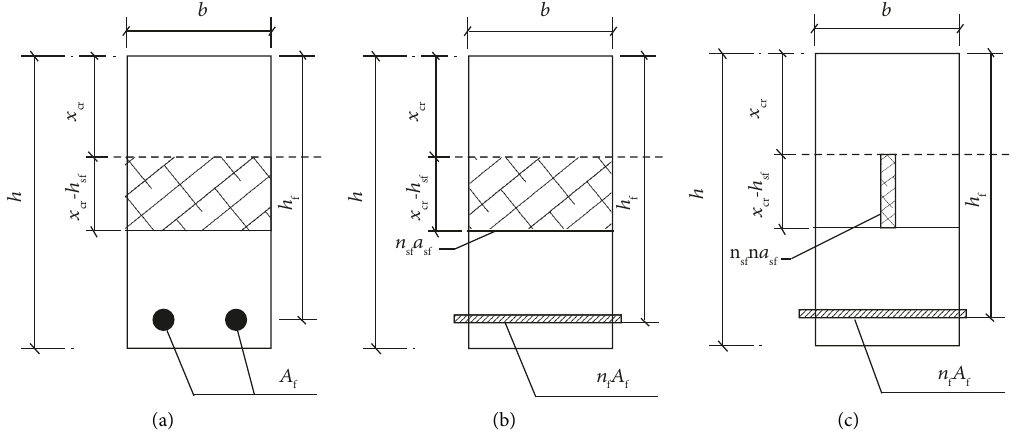
Figure 10: Equivalent simplified Graphics. (a) cracked section. (b) Converted section. (c) Equivalent conversion